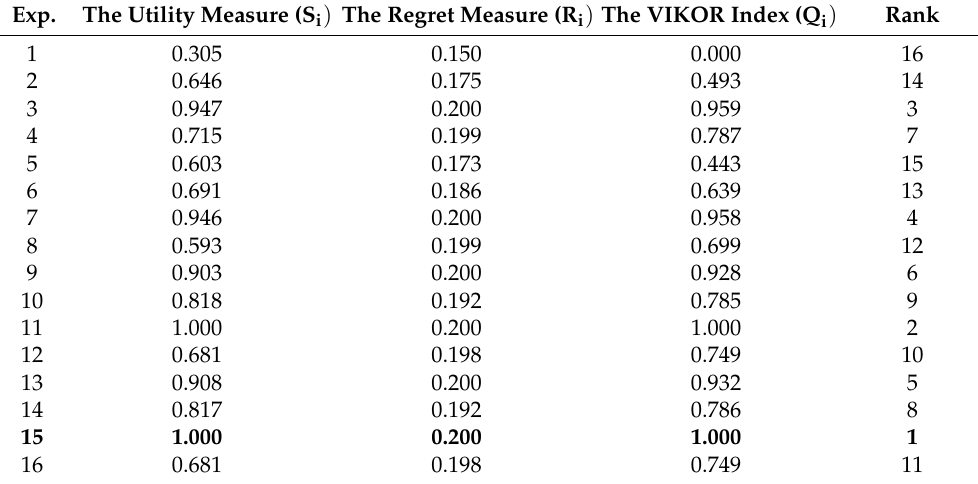
Table 8. VIKOR results.